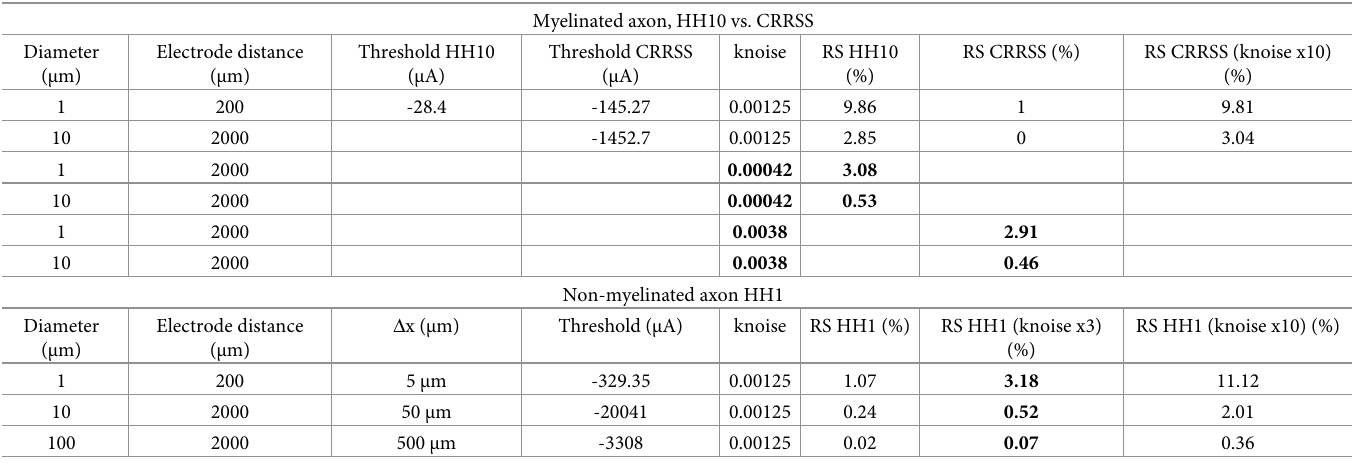
Table 3. Thresholds and RS for the HH1, HH10 and CRRSS model.